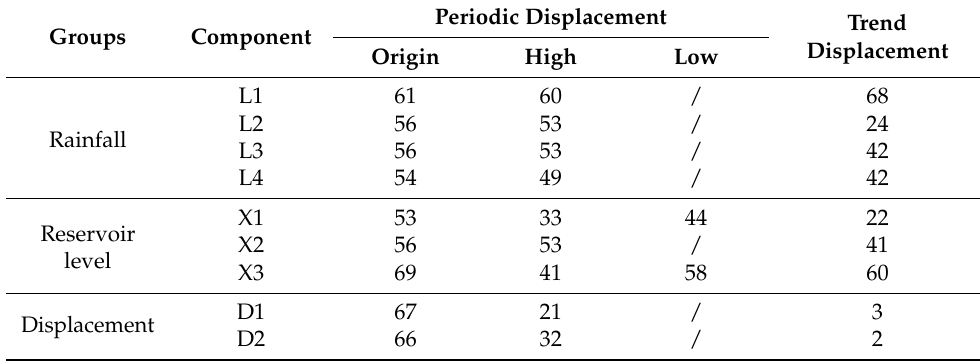
Table 2. EDR distance between periodic displacements and related factors.